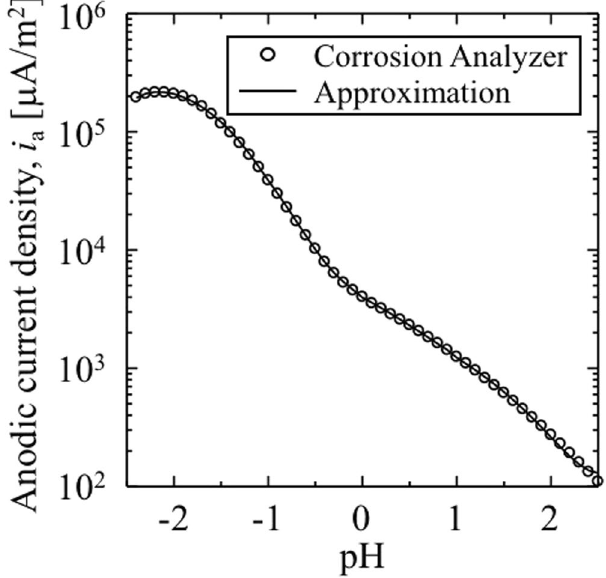
Figure 9. Anodic current density evaluated as a function of the pH of the acid solution at 60 °C. White circles and black line denote the anodic current density at the corrosion potential calculated by Corrosion Analyzer and the approximated curve used in the simulation of the pitting corrosion,